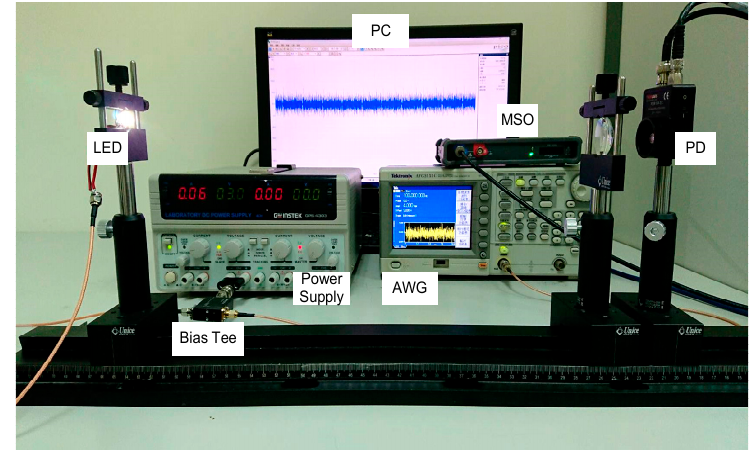
Figure 11. Experimental setup of the DCO-OFDM VLC testbed. A PD (THORLABS PDA10A-EC), with a 150 MHz bandwidth, 1 mm 2 active area, and